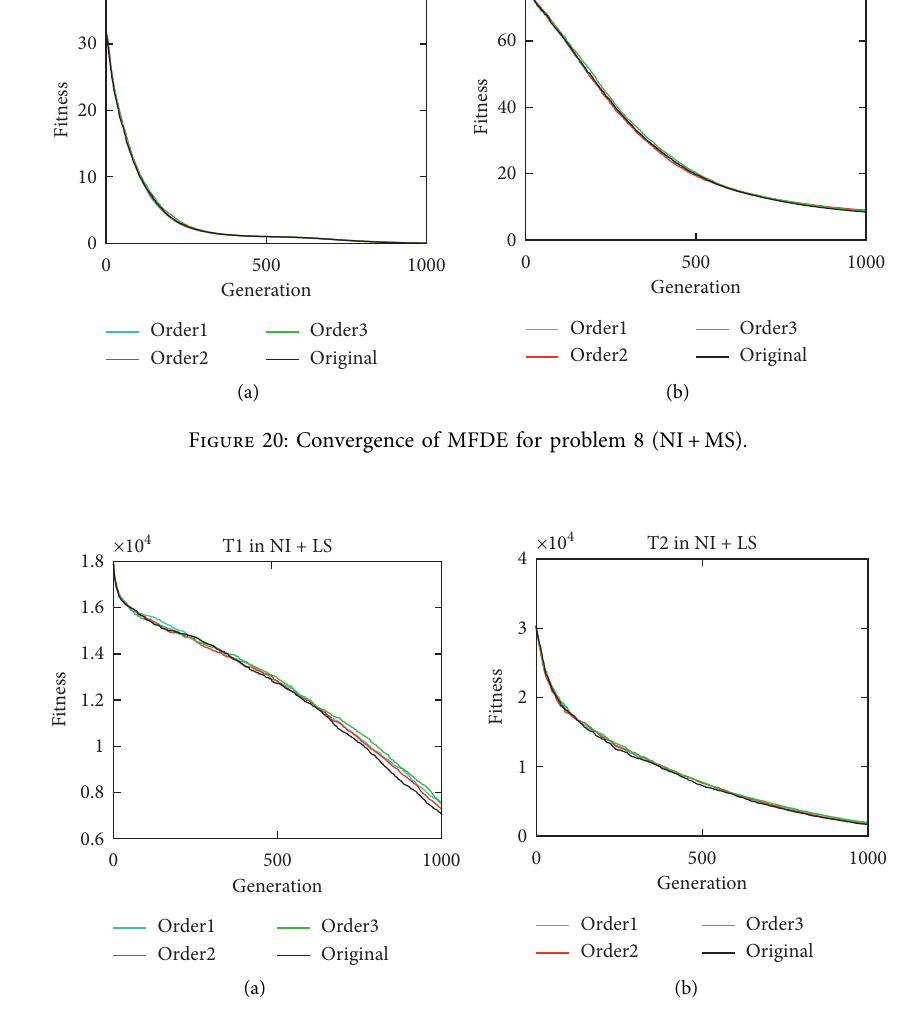
Figure 21: Convergence of MFDE for problem 9 (NI